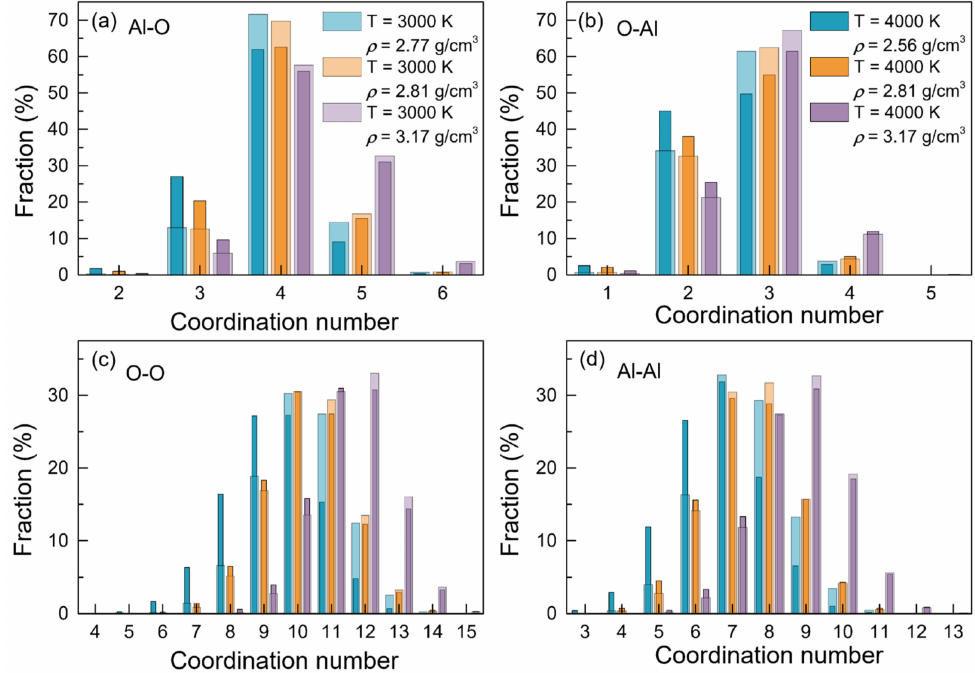
Figure 3. Coordination number distributions for the configurations of liquid alumina with three densities respectively at 3000 K and 4000